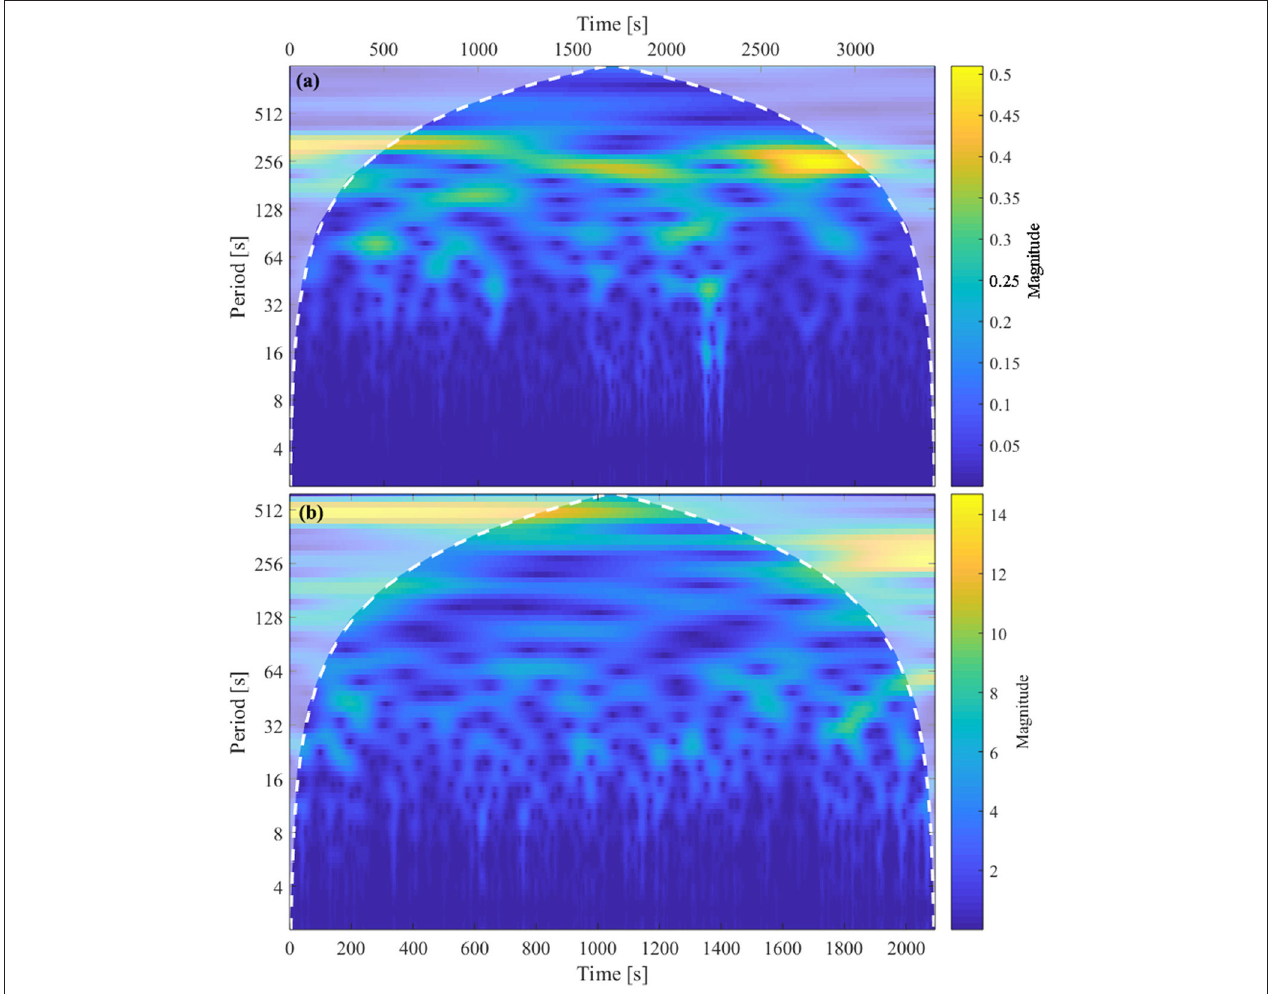
FIGURE 7 | Wavelet power spectrum analysis of synchronous data from 18/06/17 of (a) UV camera emission rates and (b) the thermal camera data, showing a potential periodicity at ∼ 200–300s in the UV data which isn’t shared in the thermal time series. Dashed white line indicates the wavelet cone of influence. Note differing times on the x